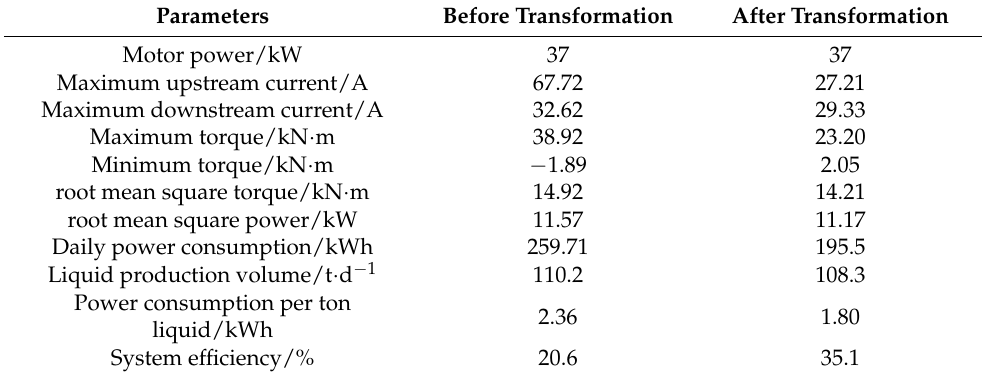
Table 1. Comparison of working conditions of B2-D2-56 pumping well before and after